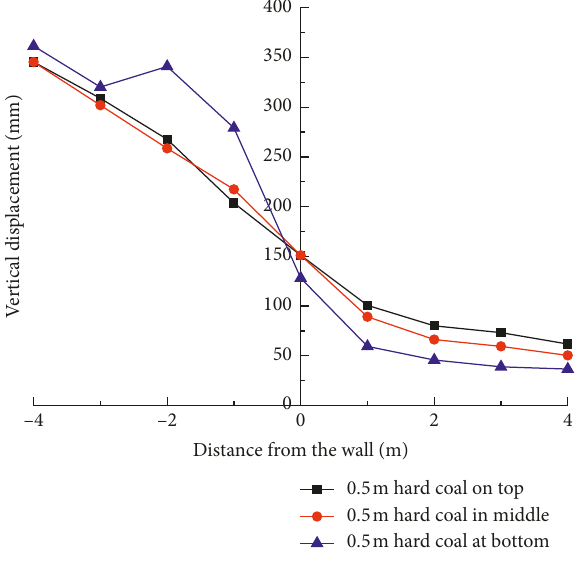
Figure 7: Vertical displacements of 0.5m thick high-strength medium-strength coal seam and top coal.